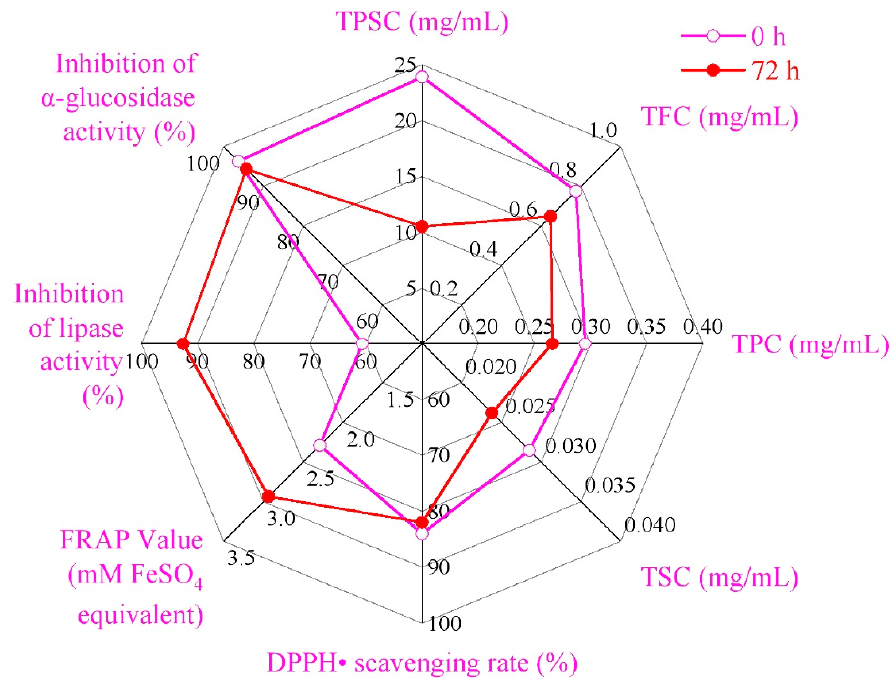
Figure 6. Radar chart of functional components and weight loss efficacy in vitro of SHLE before and after fermentation by L. fermentum grx08.